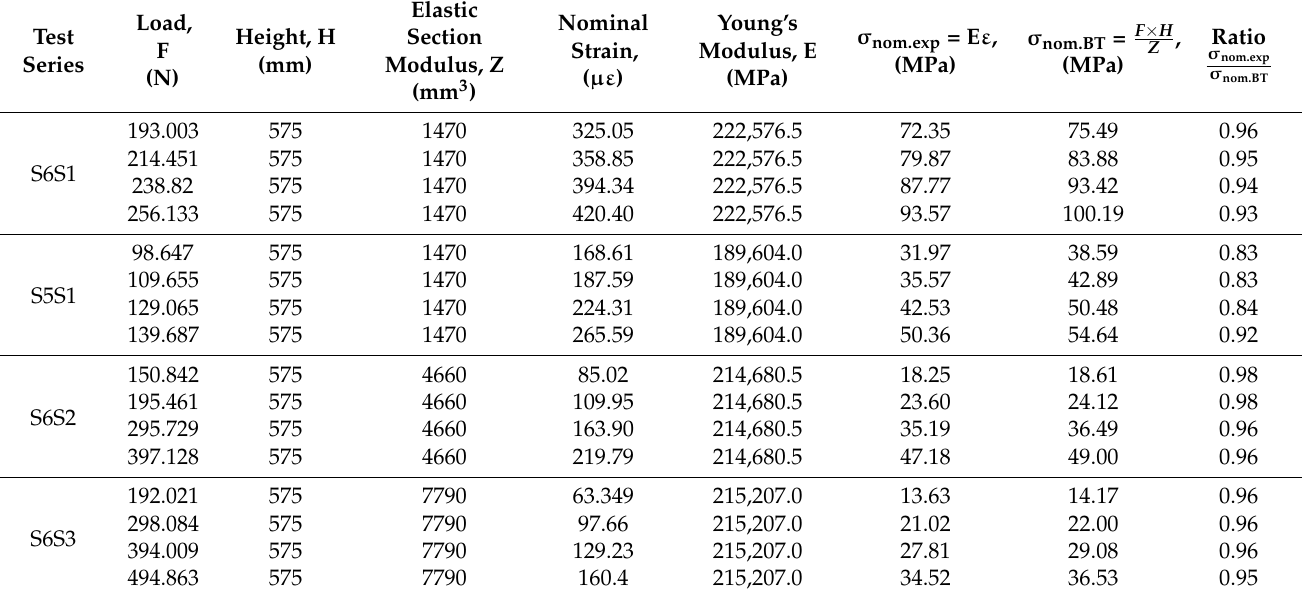
Table 3. Nominal stresses from experiment and simple beam